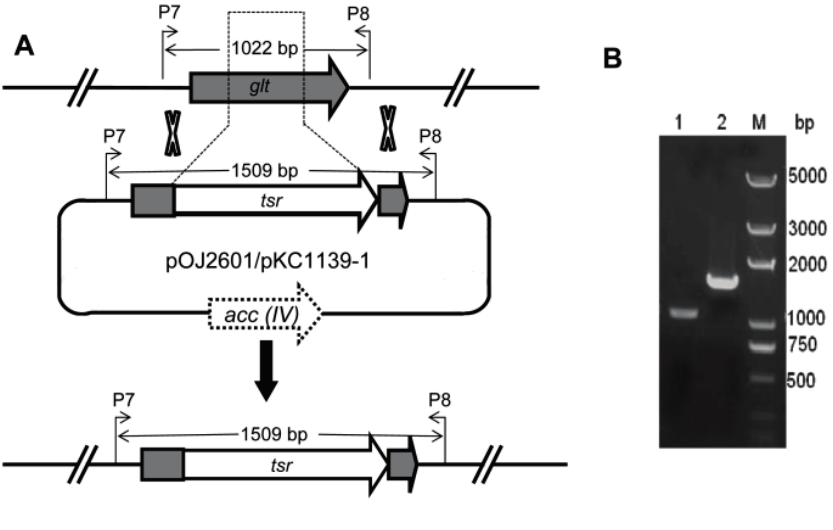
Figure 4. Inactivation of glycosyltranferase gene by gene deletion. ( A ) Construction of deletion mutants of glt ; and ( B ) Verification of the double crossover mutants by PCR from wild-type (1022 bp) and mutant strain (1509 bp). Lane 1: wild-type strain; lane 2: mutant strain; M: